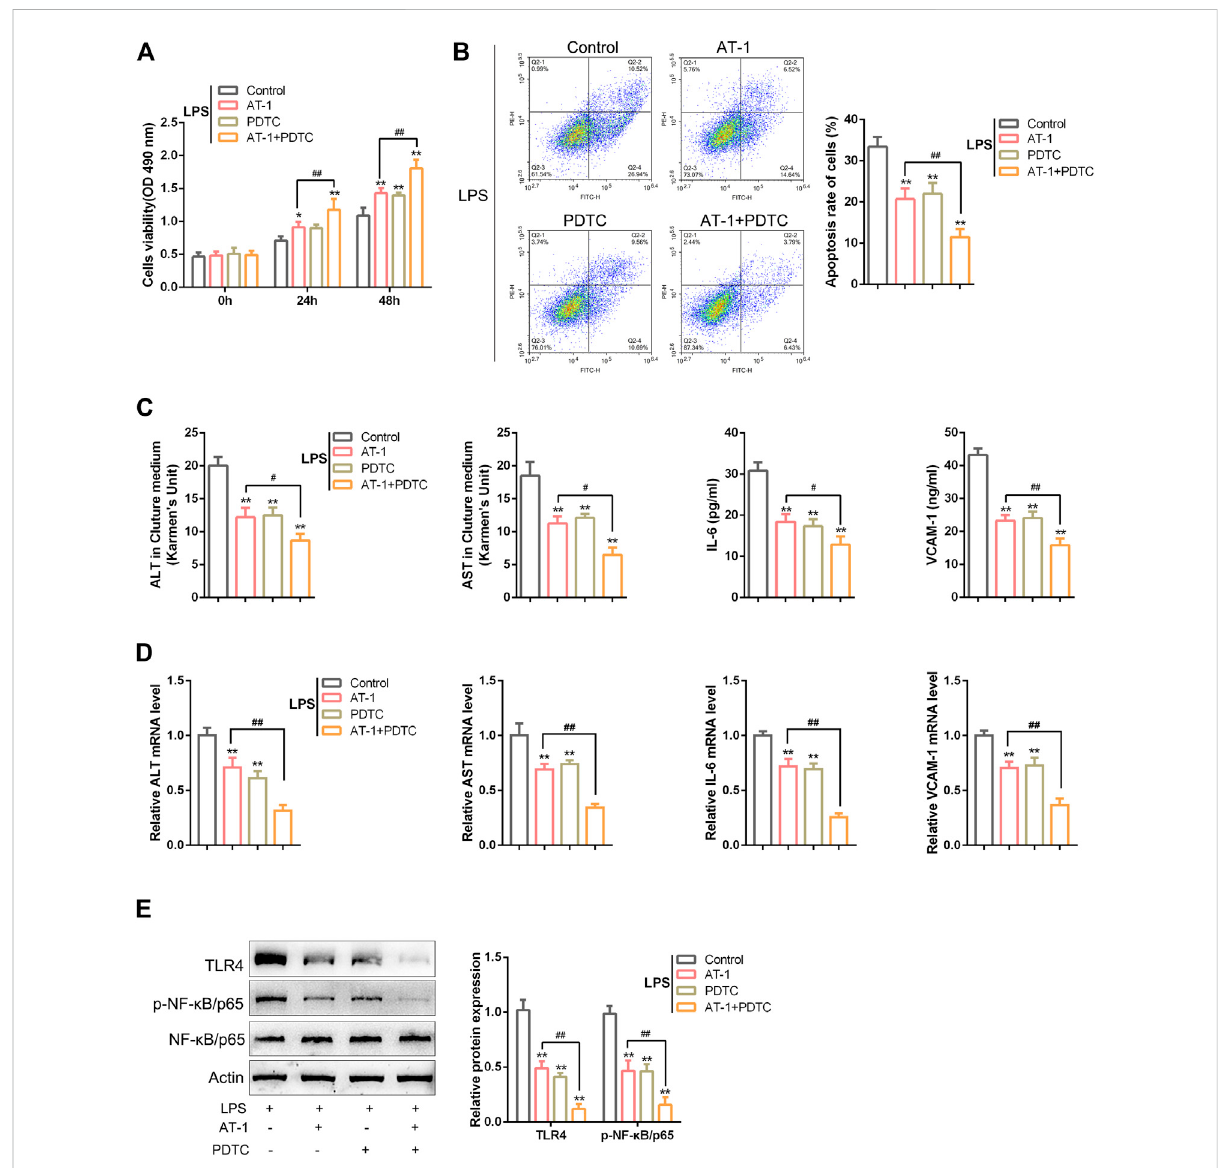
FIGURE 5 NF- κ BsignalingisinvolvedinAT-1effectsonLPS-inducedtoxicityinBRL3Acells.TargetcellsweretreatedwithAT-1(10 µM)and/orPDTC(the NF- κ B signaling inhibitor, 10 µM) under LPS stimulation and examined for cell viability using CCK-8 assays (A) , cell apoptosis by fl ow cytometry (B) , levelsofALT,AST,IL-6,andVCAM-1intheculturemediumorcellsusingcorrespondingkitsorqRT-PCRassay,respectively (C – D) ,andproteinlevels of TLR4, p-NF- κ B/p65, and NF- κ B/p65 by immunoblotting (E) . N = 3; * p < 0.05, and ** p < 0.01 compared to the control group; # p < 0.05 and ## p < 0.01 compared to the AT-1